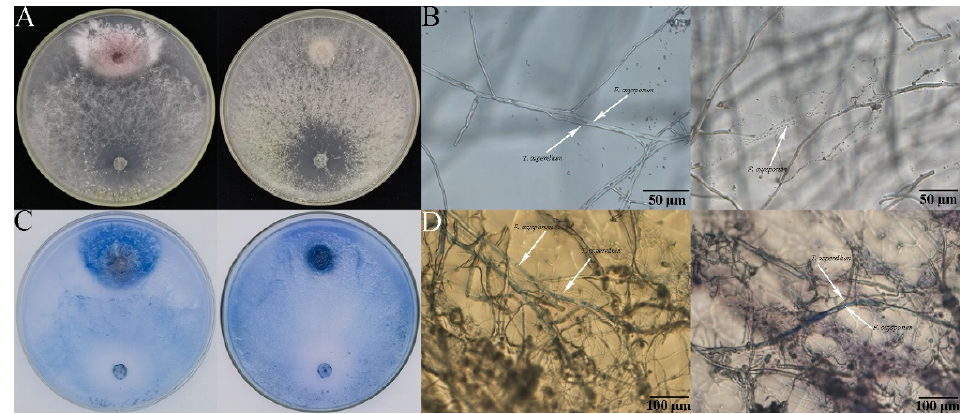
Figure 3. Observation of the interaction zone between T. asperellum SC012 and F. oxysporum FC018. ( A ), Dual culture of T. asperellum SC012 and F. oxysporum FC018 at the presence (right) or absence (left) of 50 µg mL − 1 hymexazol. ( B ), Hyphae of F. oxysporum FC018 encircled (left) and disintegrated (right) by T. asperellum SC012. ( C ), Trypan blue staining of T. asperellum and F. oxysporum at the presence (right) or absence (left) of 50 µg mL − 1 hymexazol. ( D ), Stained hyphae of F. oxysporum .